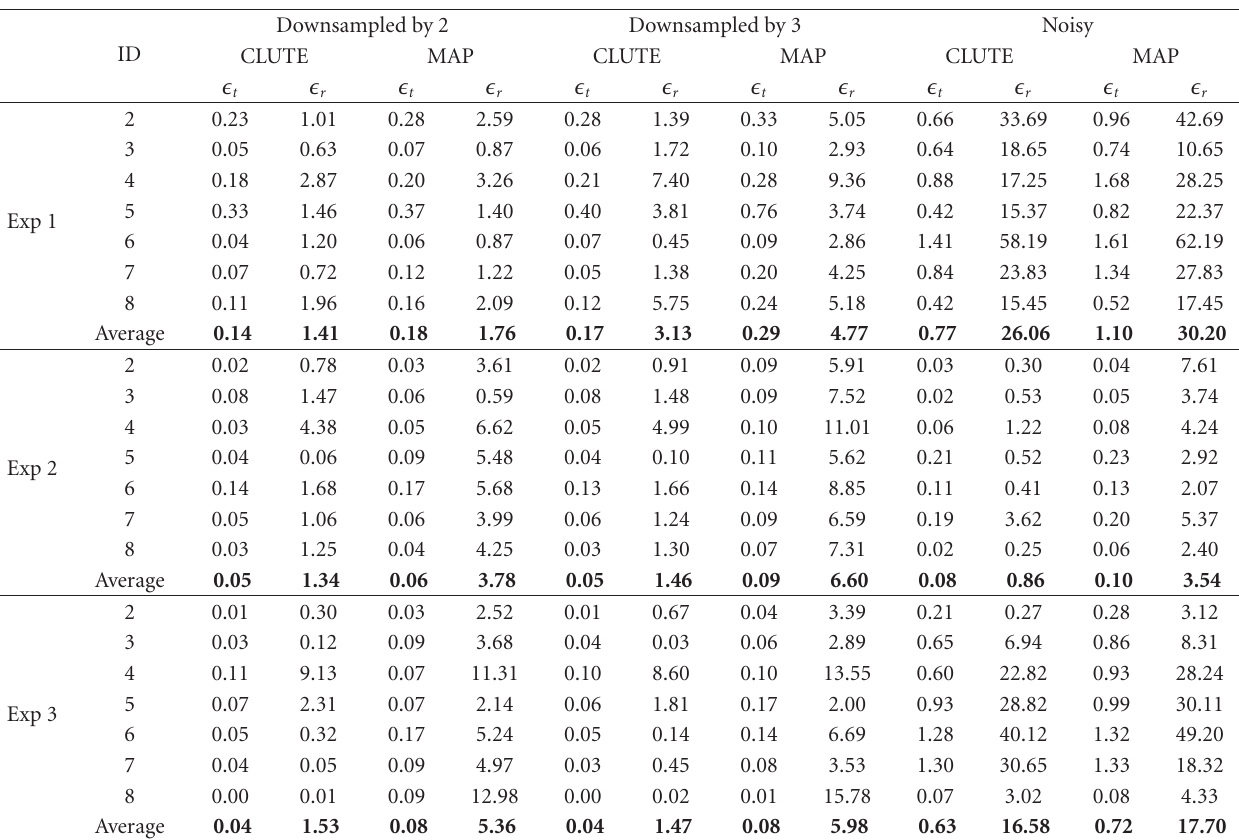
Figure 12: CLUTE localization results with a 8-camera network: (a) experiment 1 dataset; (b) experiment 2 dataset, (c) experiment 3 dataset. Table 7: Performance comparison between CLUTE , MAP , and MDS on the three datasets for missing and noisy data (8-camera